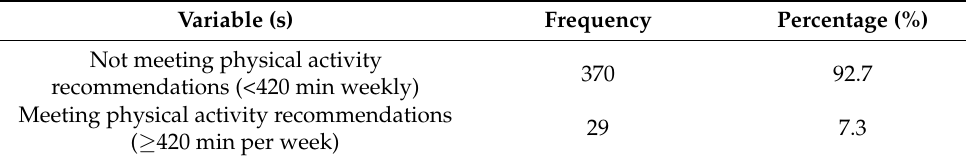
Table 3. Distribution of participants by physical activity